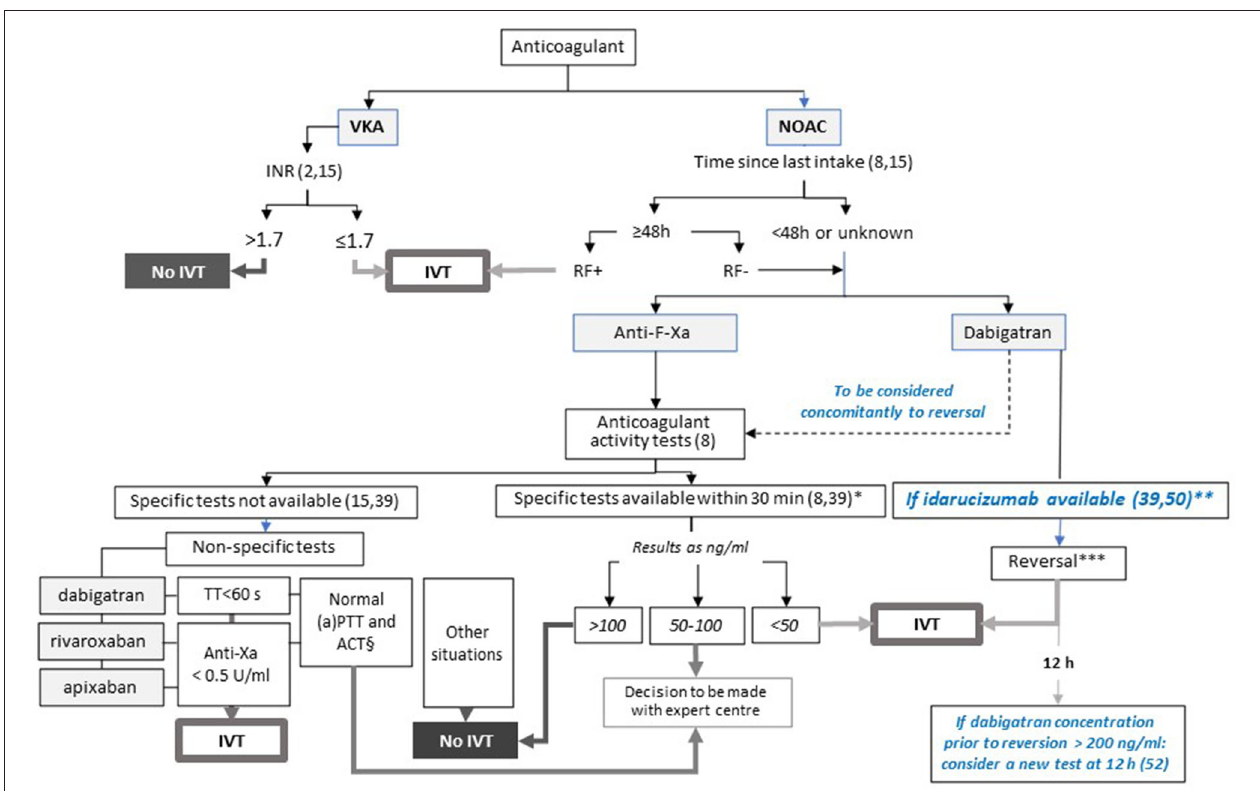
FIGURE 1 | Proposed algorithm for the management of ischemic stroke in patients eligible for IVT according to the anticoagulant, and local specificities. This figure presents the decision-making process for IVT in patients presenting with IS. In case of proximal and large vessel occlusion, MT should be considered alone or coupled with IVT. Steps in blue are based on data from the literature and are not mentioned in the current guidelines. *Based on usual practise. **Consider dabigatran dosing if a high concentration is suspected. *** To be undertaken before dabigatran concentration is known. In case of high concentration of dabigatran ( > 200ng/ml) prior to reversal, consider assessment of anticoagulation activity 12h after reversal and, if dabigatran concentration > 50ng/ml, a second administration of idarucizumab. § For dabigatran and rivaroxaban. ACT, activated cephalin time; aPTT: activated partial thromboplastin time; IVT: intravenous thrombolysis; RF + /RF-: normal (creatinine clearance ≥ 50 ml/min) or abnormal renal function according to the last dosage available; TT: thrombin